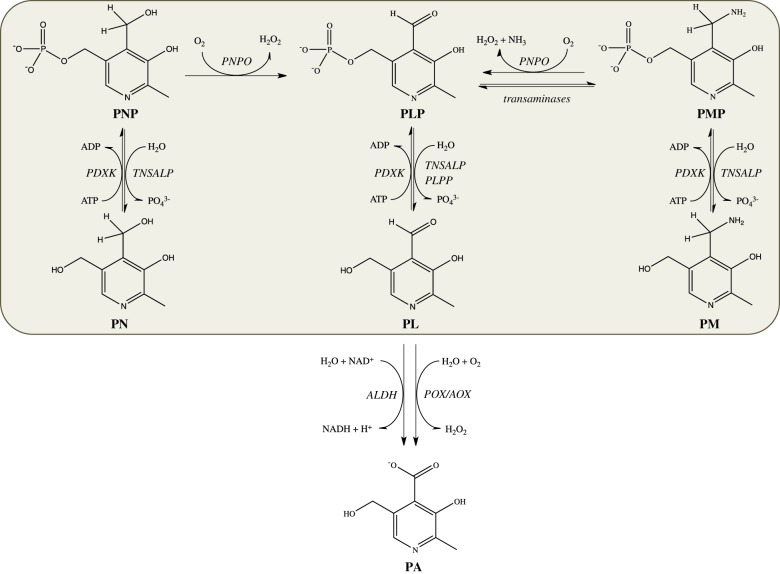
Schematic of vitamin B6 metabolism in humans. The orange diagram corresponds to the pyridoxal 5′-phosphate salvage pathway. PLP, pyridoxal 5'-phosphate; PNP, pyridoxine 5'-phosphate; PMP, pyridoxamine 5'-phosphate; PL, pyridoxal; PN, pyridoxine; PM, pyridoxamine; PA, 4-pyridoxic acid; PDXK: pyridoxal kinase; TNSALP: tissue-non-specific alkaline phosphatases; PLPP, pyridoxal 5'-phosphate phosphatase; ALDH, aldehyde dehydrogenases; POX, pyridoxal oxidase; AOX, aldehyde oxidases.